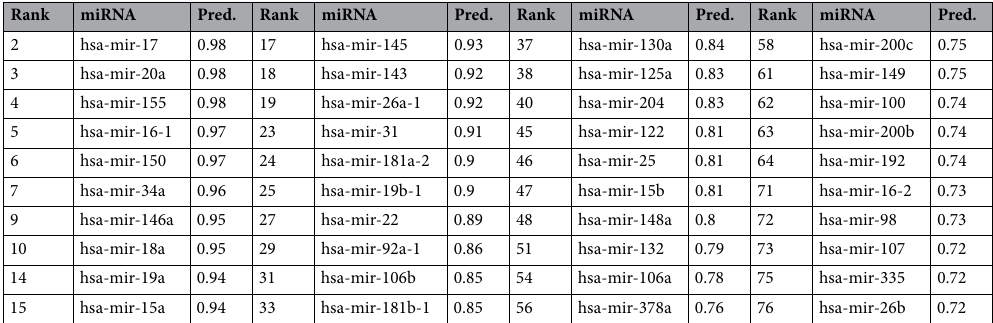
Table 9. The top miRNAs with the highest prediction scores that appear in L —the list of associated miRNAs output from the survival